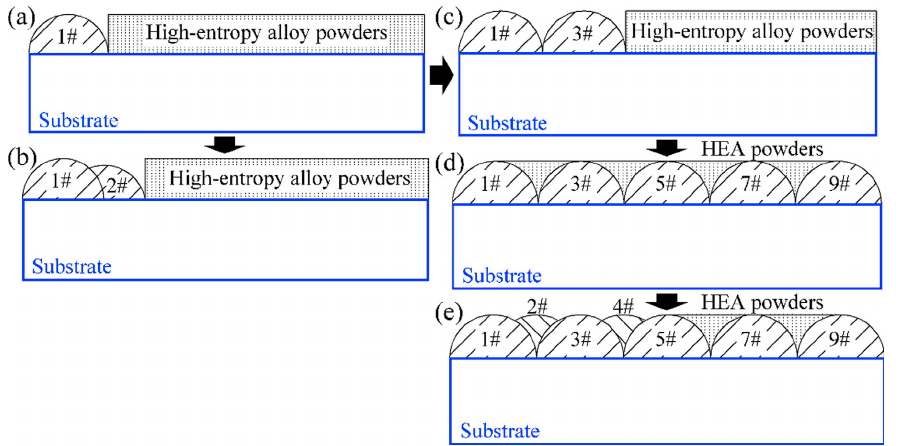
is most probably due to the partial melting of a stainless steel substrate.